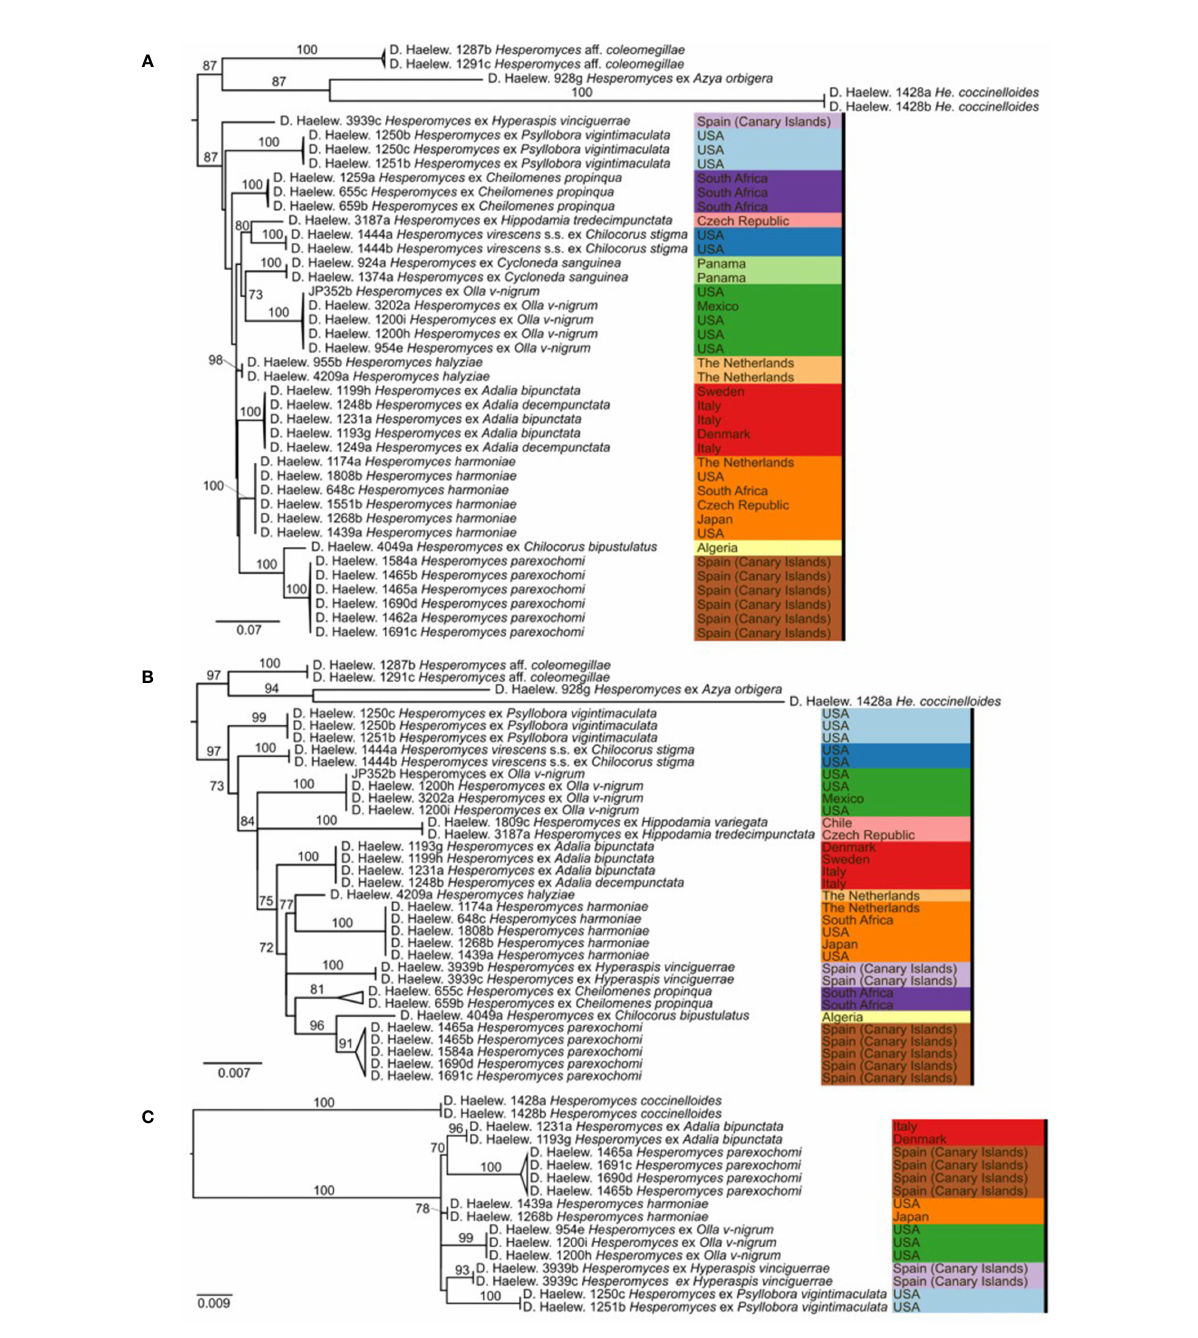
FIGURE 3 Phylogenies of the Hesperomyces virescens species complex, reconstructed from the internal transcribed spacer (ITS) (A) , large subunit (LSU) (B) , and minichromosome maintenance complex component 7 ( MCM7 ) (C) datasets. For every node, the ML bootstrap value ( ≥ 70) is given above or next to the branch leading to that node. Species within the He. virescens complex are each indicated with their own color, as in Figure